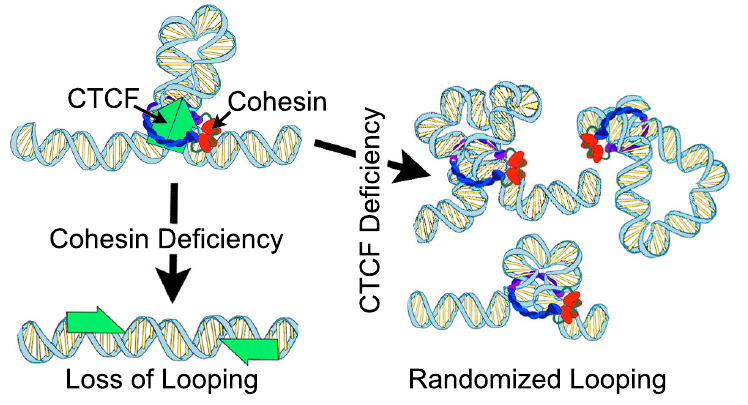
Figure 1. Different outcomes of CTCF v.s. cohesin deficiencies. CTCF and cohesin work in concert to establish loops between CTCF anchors. Loss of either results in a loss of CTCF-specific loops. However, due to their distinct roles, the loss of CTCF is thought to have different molecular impacts from the loss of